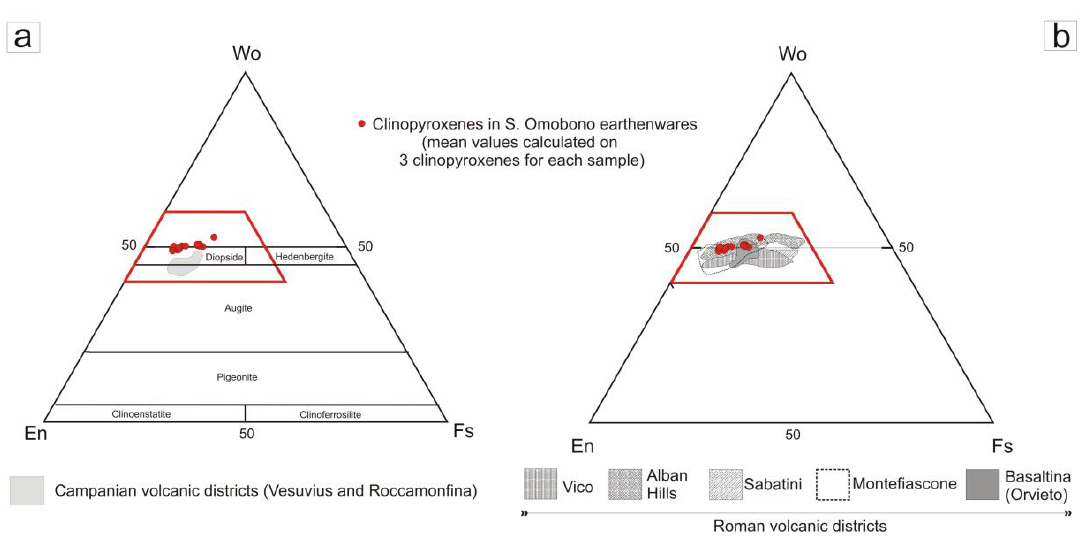
Figure 5. Classification of clinopyroxenes [59] using data obtained by EPMA and comparison between the composition of the clinopyroxenes analyzed in the archaeological samples of S. Omobono with those from the Campanian volcanic province ( a ) and the Roman volcanic complexes and districts ( b ).